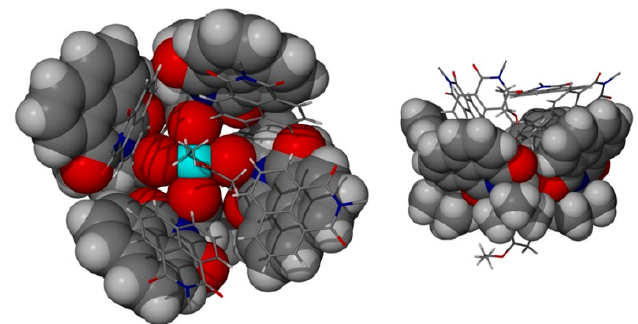
Figure 5. Space filling structure of bis(EtOAc) adduct of Rh 2 ( S ‐ NTTL) 4 (top and side view). (Reprinted